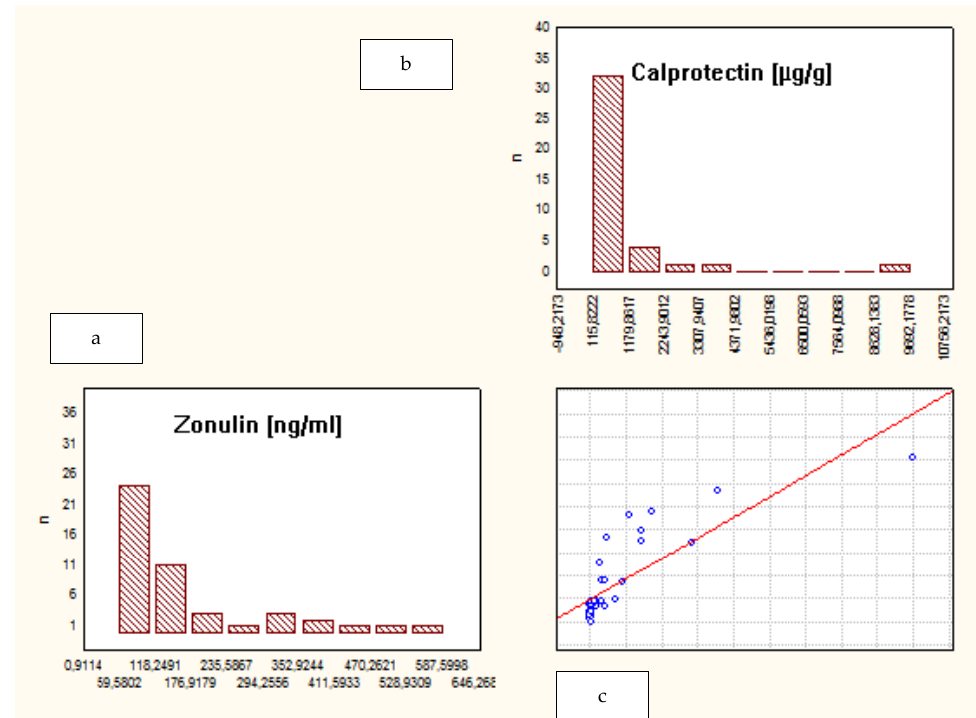
Figure 2. Correlation between fecal zonulin and calprotectin levels in patients with CD. ( a ) Levels of fecal zonulin in patients with CD; ( b ) levels of fecal calprotectin in patients with CD; ( c ) the correlation between levels of fecal zonulin and calprotectin in patients with CD.